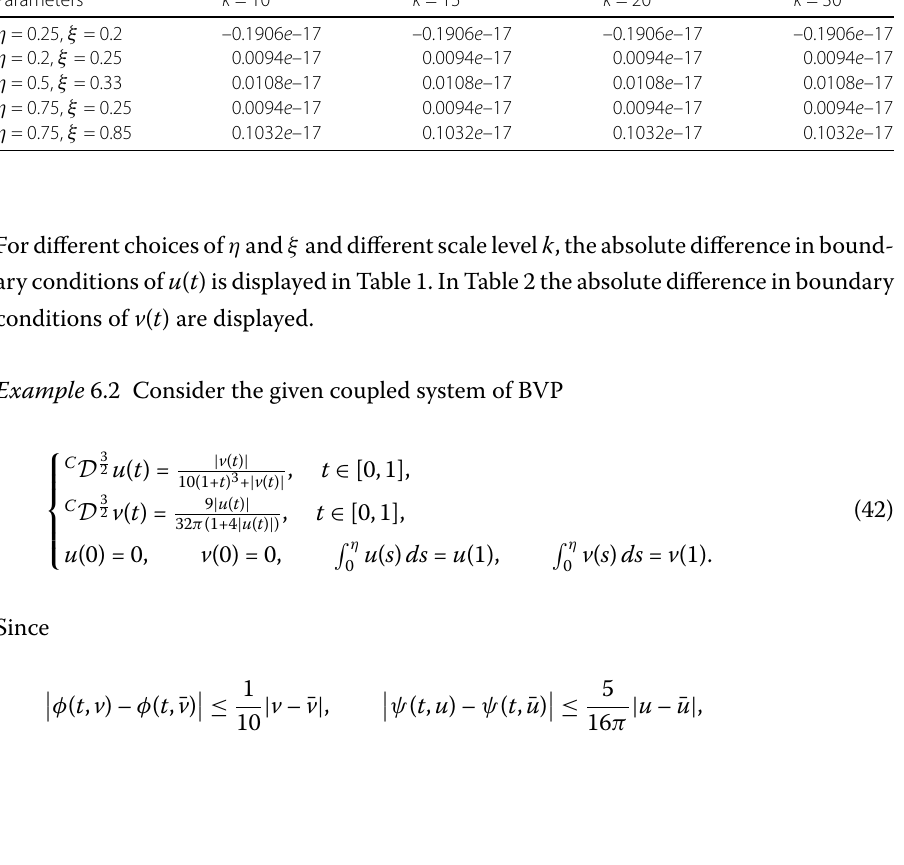
Table 2 Absolute error in boundary conditions of v ( t ) of Example 6.1 using different choice of parameters Parameters k = 10 k = 15 k = 20 k = 30 η = 0.25, ξ = 0.2